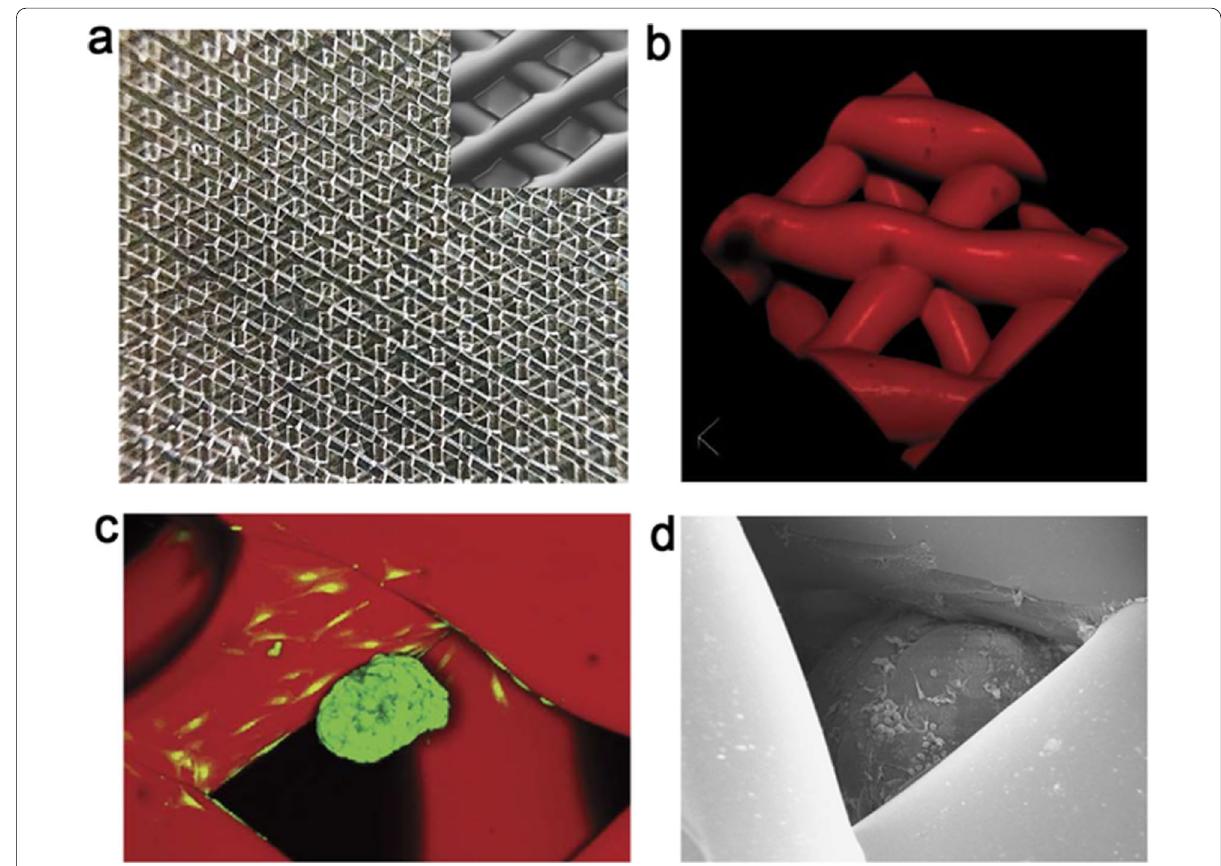
Fig. 4 Ovarian follicles cultured in 3D printed microporous gelatin scaffolds. a Macroscopic view of 3D printed microporous gelatin five-layered scaffolds printed with a 100 mm nozzle. b 3D reconstructions of a confocal fluorescence image of 60° angle gelatin scaffolds. c Confocal fluorescence image of follicles seeded in pores after 2 days of culture. d Electron micrograph of an ovarian follicle wedged underneath 60° angle gelatin scaffolds after 2 days of culture. Reproduced with permission from [77]